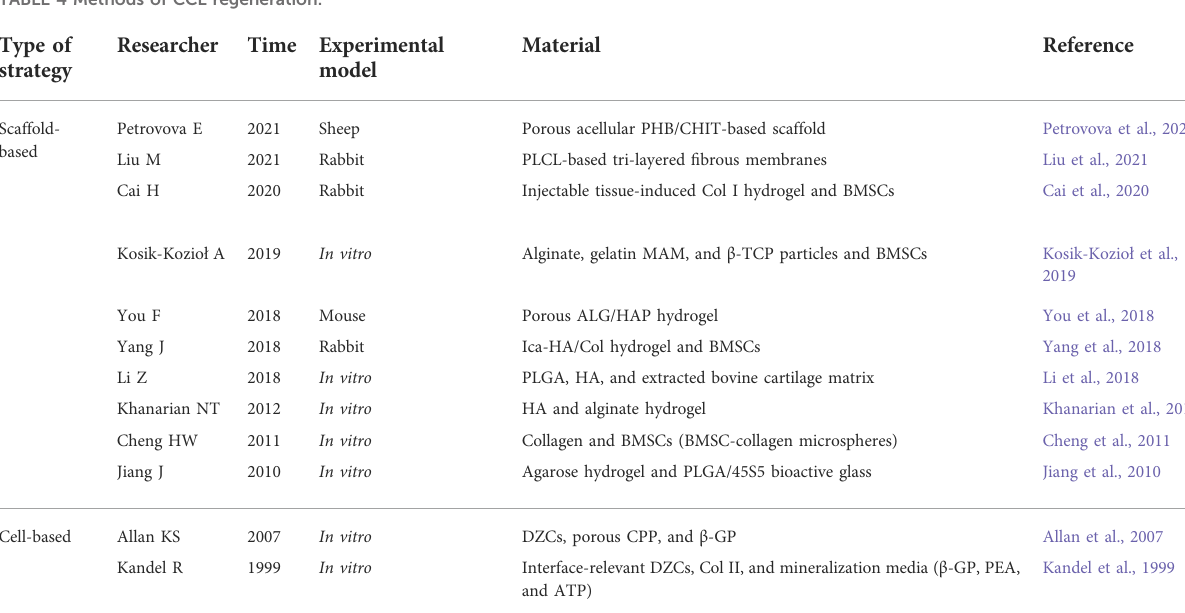
TABLE 4 Methods of CCL